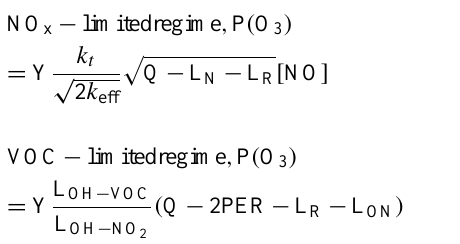
√ ( Q − 2PER − L R − L ON ) , Q, and NO during the daytime (06:00– Q − L N − L R [ NO ] , L OH − VOC L OH − NO2